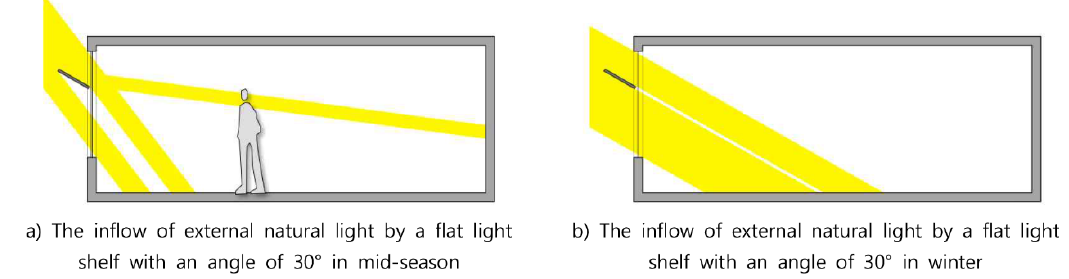
Figure 12. Inflow of natural light by the light shelf in mid-season and winter. Table 7. Optimal specifications and lighting energy consumption of the flat light shelf.